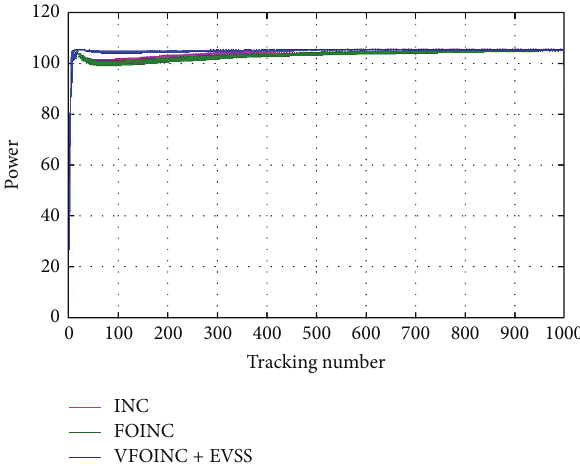
Figure 9: Comparison of INC and FOINC and VFOINC with EVSS (fixed irradiance).